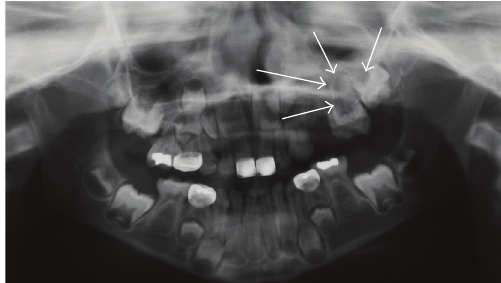
Figure 1: Panoramic radiograph showing lack of/delayed eruption of teeth in the left maxilla.